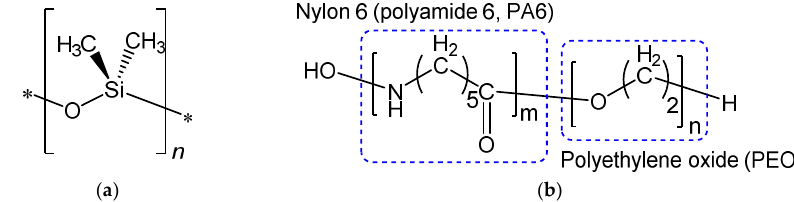
Figure 1. Chemical structures of polymers used for double layer membrane fabrication: ( a ) polydimethylsiloxane (PDMS) and ( b ) general structure of Pebax ® polymer family containing different amounts of polyamide 6 and polyethylene oxide blocks in the structure.